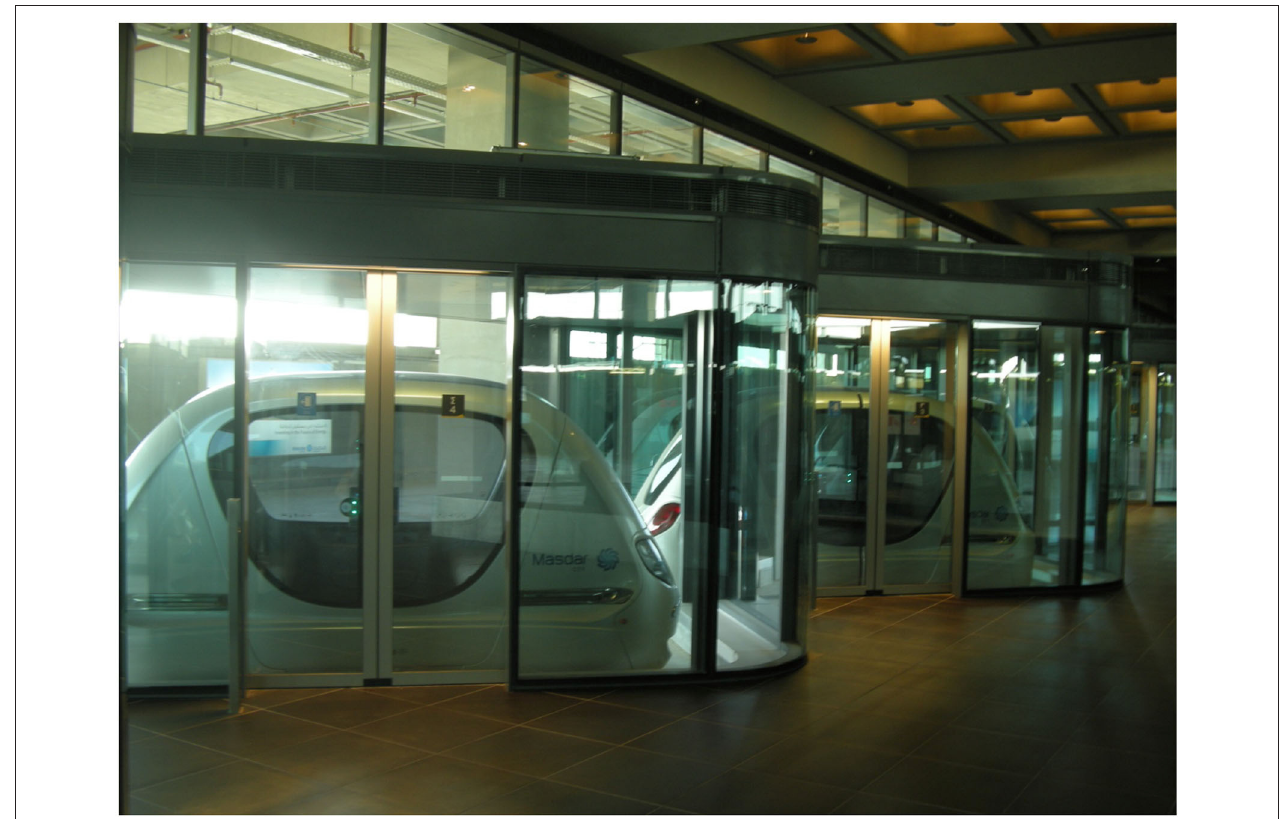
FIGURE 1 | PRT driverless cars in a station located in Masdar City’s undercroft. Source: author’s original.